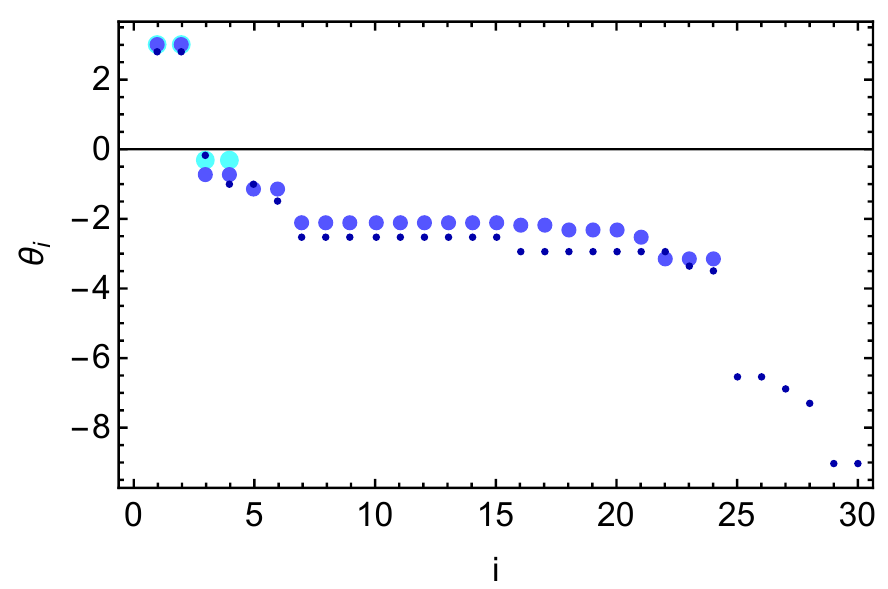
Figure 5 . We show the real parts of the critical exponents in the T 4 (large cyan dots), T 6 (medium light blue dots) and T 8 (small blue dots)